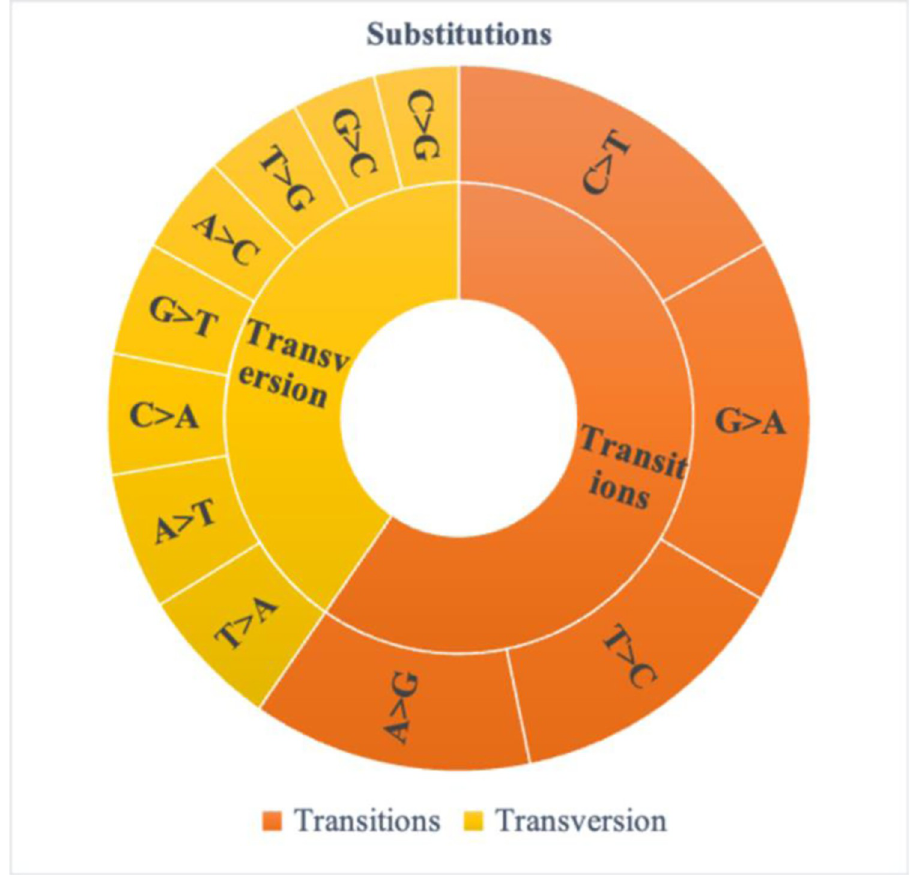
Fig 1. Number of transitions and transversion of nucleotide in genotyping by sequencing analysis.